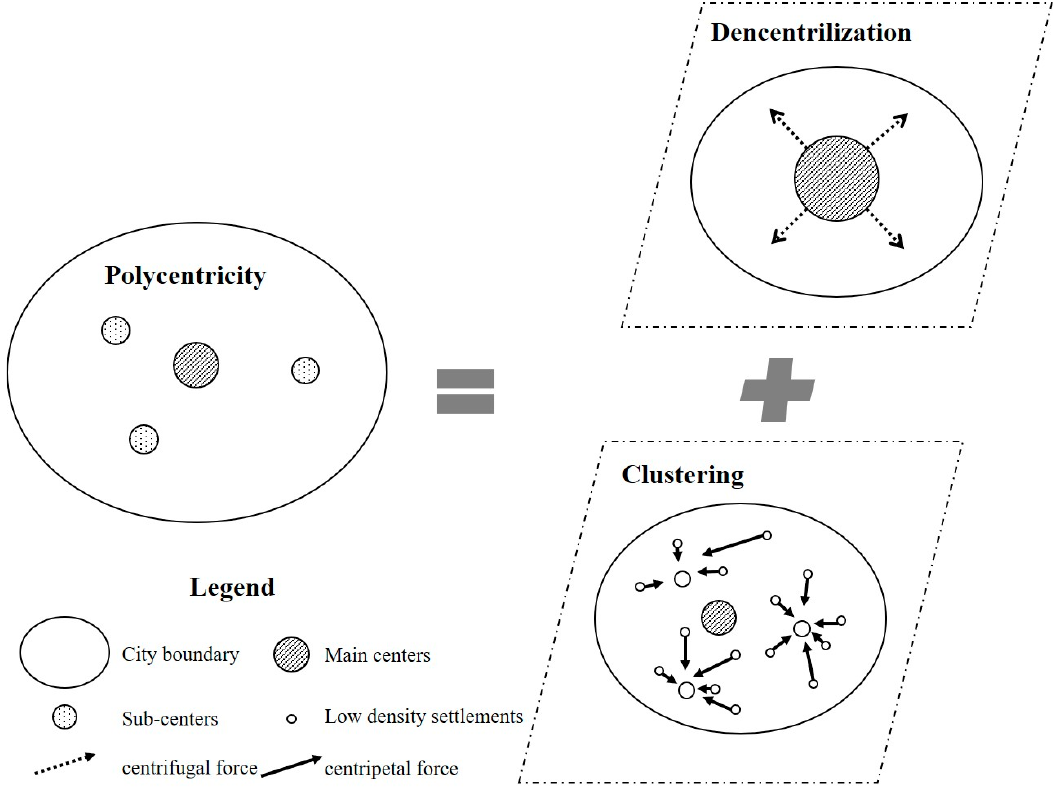
Figure 1. Two dimensions of polycentricity (decentralization and clustering).